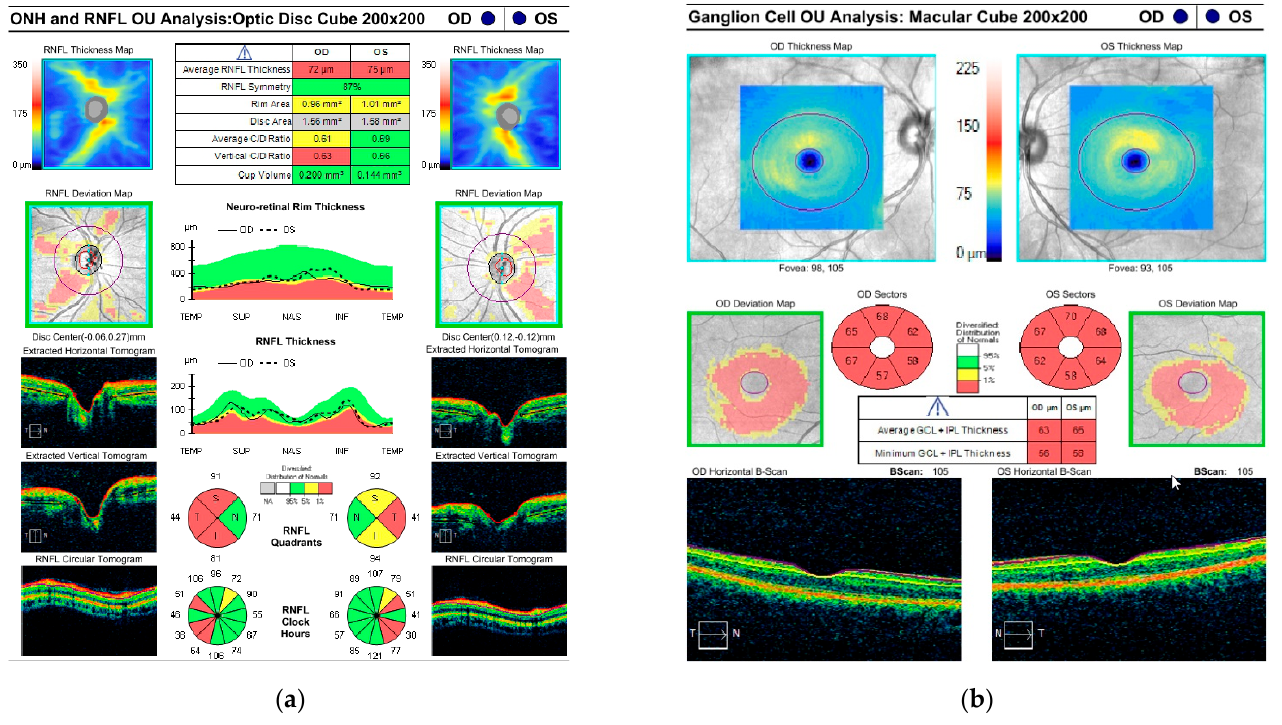
Figure 5. Optical coherence tomography (OCT) of the retinal nerve fiber layer (RNFL) ( a ) and ganglion cell layer (GCL) ( b ) of the mother. Red color represents thinning below normal values. Yellow color represents a moderate thinning. Green color represents normal values.